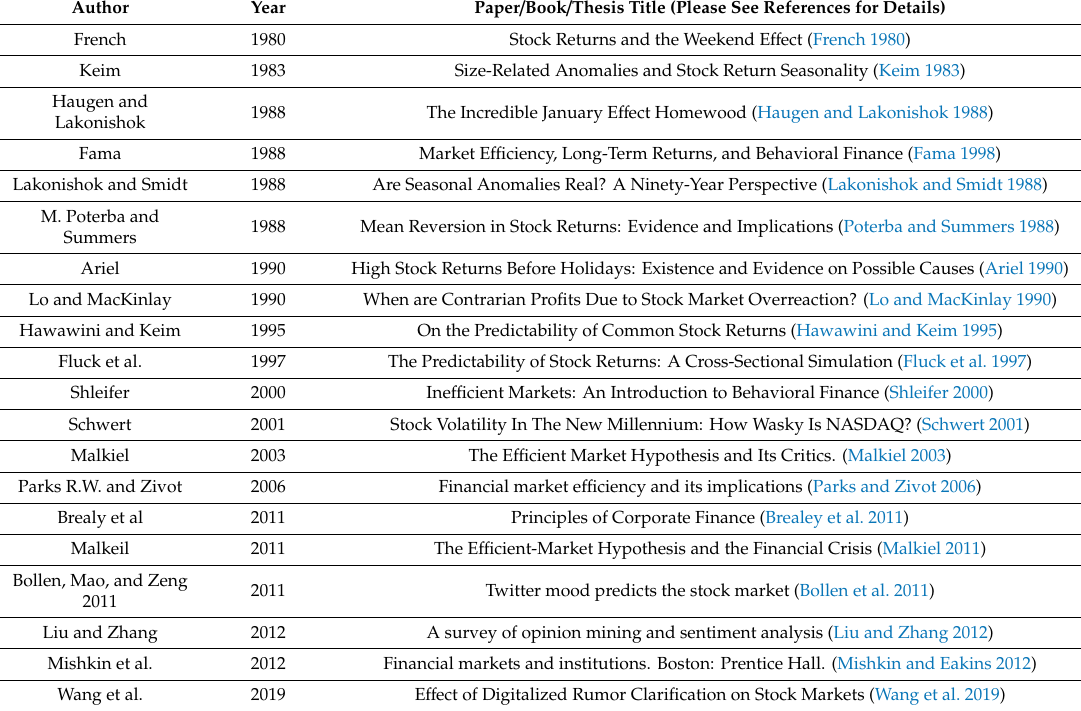
Table 2. Selected work on Critics of EMH and Modern state of